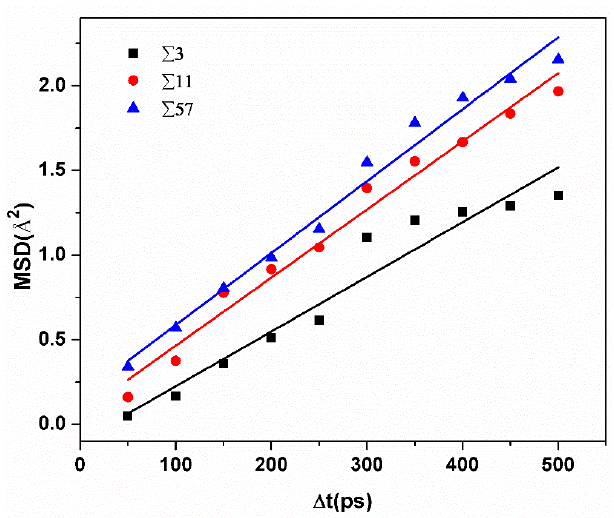
Figure 4. The comparison of the average MSD versus time of hydrogen atoms in different GBs.